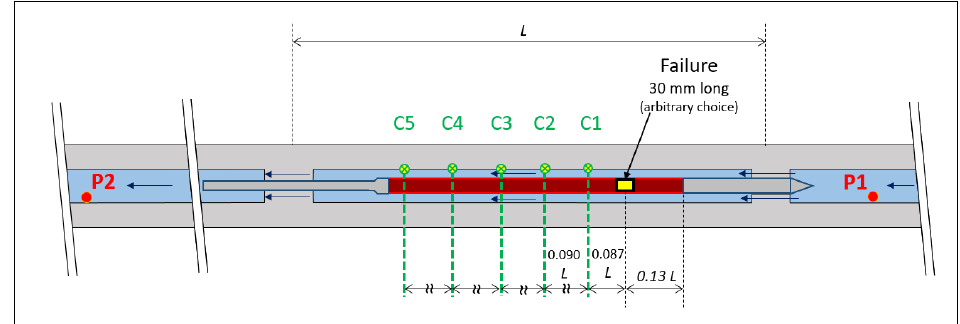
Figure 9. Positions of pressure history extraction points in the main